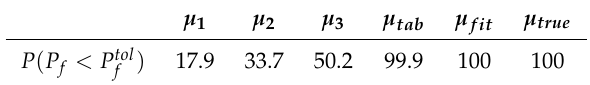
by critical values from different f